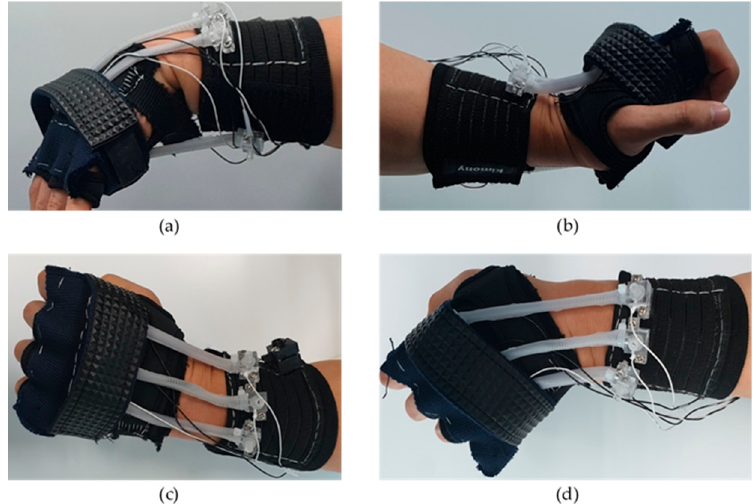
Figure 8. Four wrist motions produced by the wearable robot, ( a ) flexion, ( b ) extension, ( c ) radial deviation, ( d ) ulnar deviation.